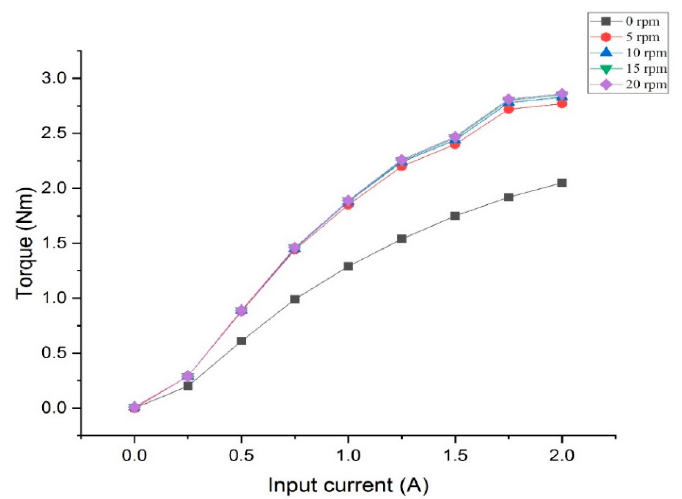
Figure 6. Relation between output damping torque with input current.